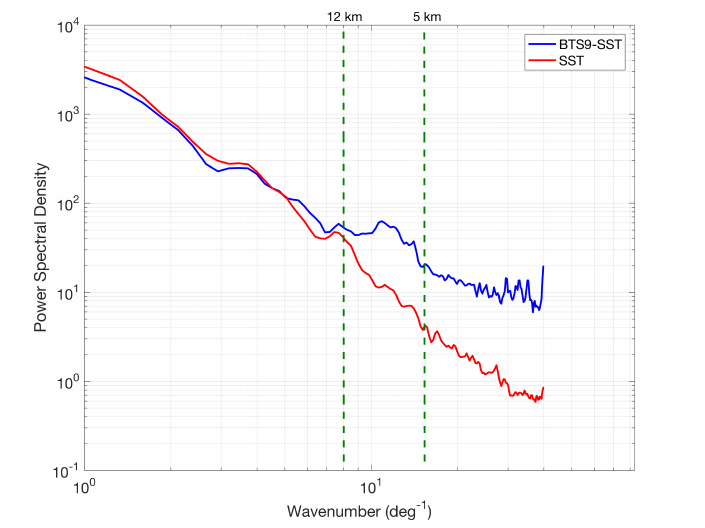
Figure 4. Power spectral density of the BT S 9 -SST (blue) and SST (red) fields computed over the area depicted in Figures 2 and 3. The relative positions of the 12 km and 5 km scales are given by the green dashed